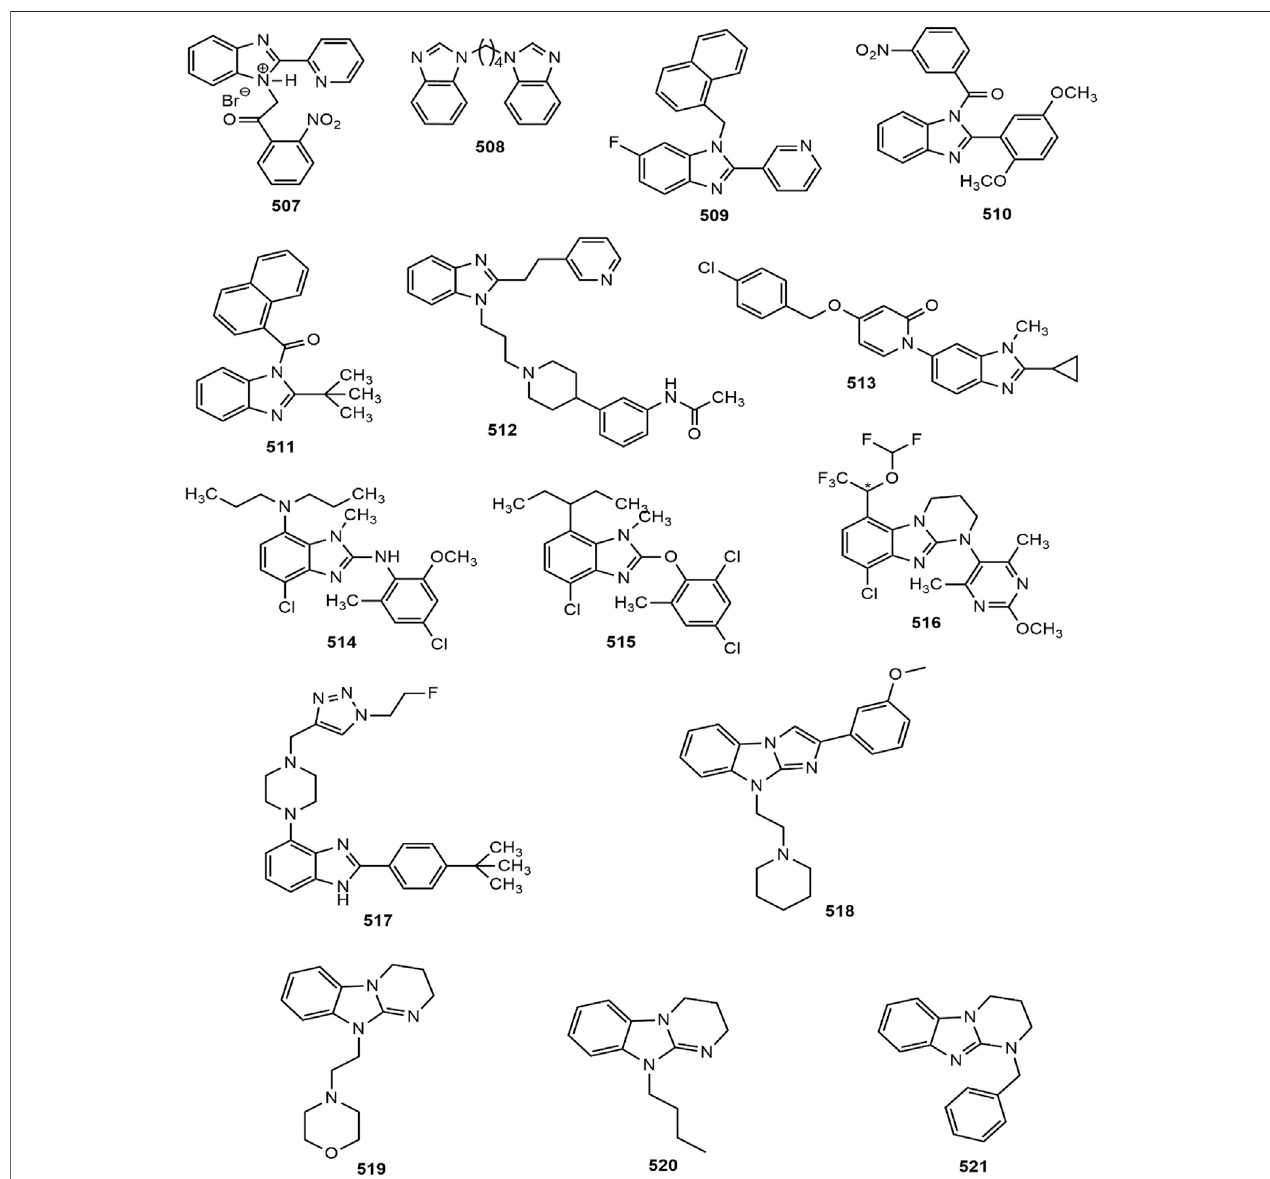
FIGURE 21 | Benzimidazole derivatives with miscellaneous